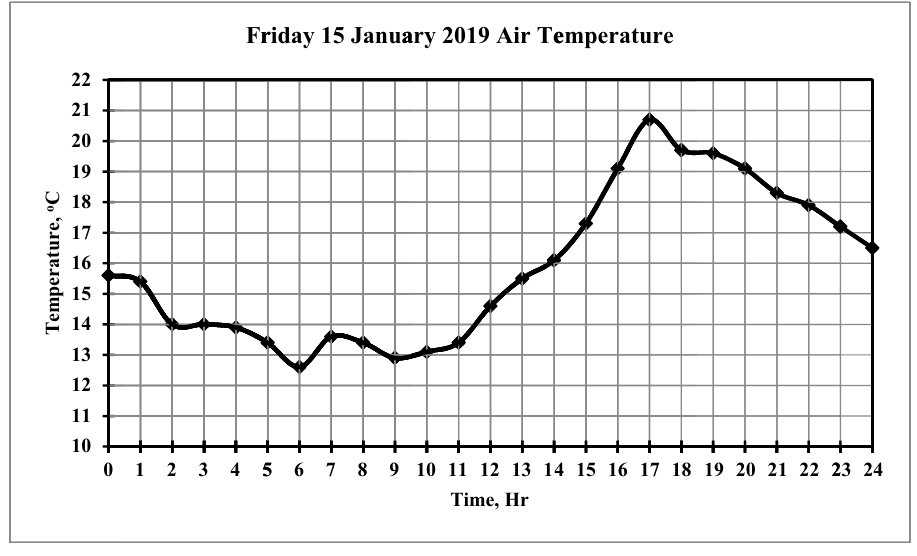
Figure 3: Relationship between air temperature and time.